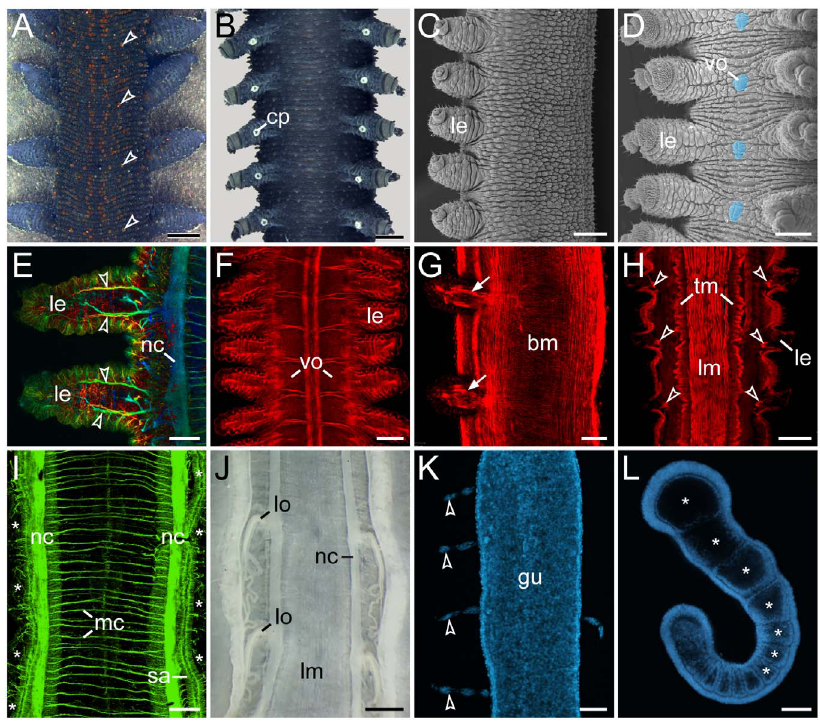
Figure 1. Segmental and non-segmental features in Onychophora. (A, B, J) Light micrographs. (C, D) Scanning electron micrographs. (E–I, K, L) Confocal micrographs. (A) Trunk of a specimen of Euperipatoides rowelli in dorsal view. Note the segmentally repeated, terracotta-coloured papillae. (B) Trunk of a male E. rowelli in ventral view illustrating segmentally arranged crural papillae. (C) Trunk of a juvenile of Metaperipatus inae in lateral view. Note that segmentation is not evident in the integument. (D) Trunk of a juvenile of M. inae in ventral view. Segmentally arranged ventral/preventral organs between each leg pair are highlighted artificially in light-blue. (E) Legs of an embryo of Principapillatus hitoyensis in dorsal view. Anti-acetylated alpha-tubulin immunolabelling. Note the segmental arrangement of the anterior and posterior leg nerves (arrowheads). (F) Segmentally repeated anlagen of the ventral and preventral organs in an embryo of Epiperipatus biolleyi in ventral view. Phalloidin-rhodamine labelling of f-actin. (G) Segmental limb muscles (arrows) in an embryo of E. rowelli in lateral view. Phalloidin-rhodamine labelling. (H) Segmental arrangement of intrinsic leg muscles (arrowheads) in E. rowelli . Horizontal Vibratome section, phalloidin-rhodamine labelling. Note that the longitudinal and transverse musculature does not show any segmentation. (I) Ventral body wall of an embryo of P. hitoyensis in dorsal view. Anti-acetylated alpha-tubulin immunolabelling. Asterisks indicate the position of legs. Note that the median commissures are not arranged in a segmental fashion. (J) Enlarged modified nephridia ( 5 labyrinth organs) in the fourth and fifth leg-bearing segments. Note their segmental arrangement. Note also the lack of segmental ganglia associated with nerve cords. (K) Dissected midgut of a fully developed embryo of P. hitoyensis with segmentally arranged cellular strands (cf. [47]). DNA staining with Hoechst. (L) Embryo of P. hitoyensis in lateral view showing the segmental somites (coelomic cavities marked by asterisks). Subset of a confocal z-series showing an optical sagittal section. Abbreviations: bm , musculature of the body wall; cp , crural papilla; gu , midgut; le , leg; lm , longitudinal musculature; lo , labyrinth organ; mc , median commissures; nc , nerve cord; sa , salivary gland; tm , transverse musculature; vo , ventral/preventral organs. Scale bars: 1 mm (A), 500 m m (B), 300 m m (C–D), 50 m m (E), 100 m m (F, G, I, K, L), 200 m m (H), 1 mm